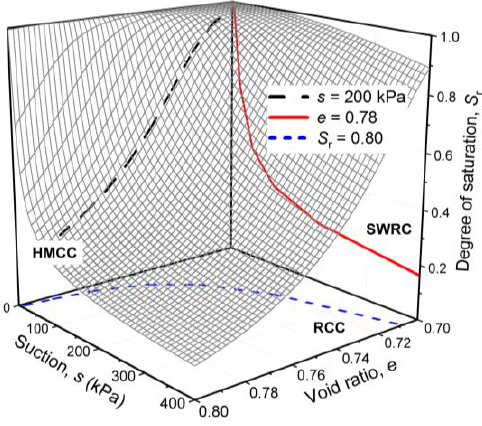
Figure 1. Schematic diagram of the three projection planes during drying.